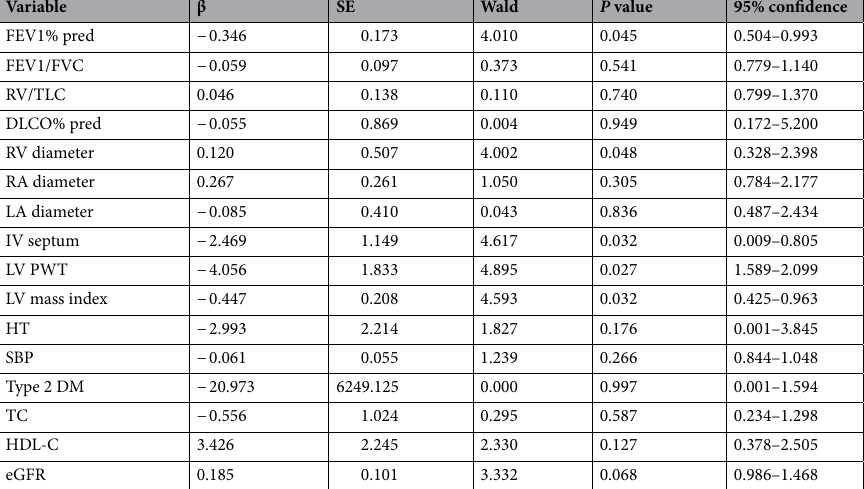
Table 3. Regression analysis of parameters associated with underweight (BMI < 18.5 kg/m 2 ) in patients with severe COPD (n = 280). COPD, chronic obstructive pulmonary disease; BMI, body mass index; FEV1, forced expiratory volume in one second; FVC, forced vital capacity; RV, residual volume; TLC, total lung capacity; DLCO, diffusing capacity of carbon monoxide; RV, right ventricular; RA, right atrial; LA, left atrial; IV, interventricular; LV PWT, left ventricular posterior wall thickness; LV, left ventricular; HT, hypertension; SBP, systolic blood pressure; DM, diabetes mellitus; TC, total cholesterol; HDL-C, high density lipoprotein cholesterol; eGFR, estimated glomerular filtration